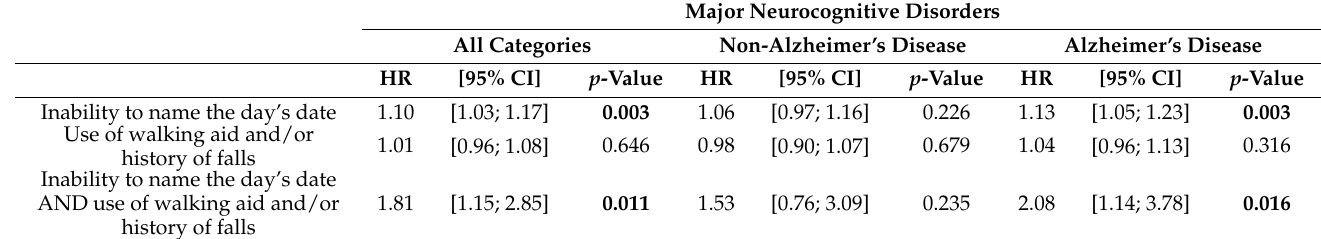
Table 2. Cox regressions showing the association of inability to name day’s date, use of walking aid and/or history of falls and their combination (independent variable; separated model for each variable) and incident major neurocognitive disorders (all categories, non-Alzheimer’s disease, Alzheimer’s disease; dependent variable; separated model for each category) in EPIDOS participants ( n =